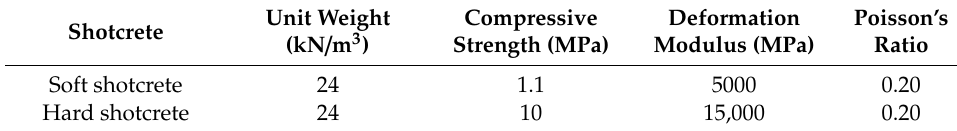
Table 3. Material properties of shotcrete used in the